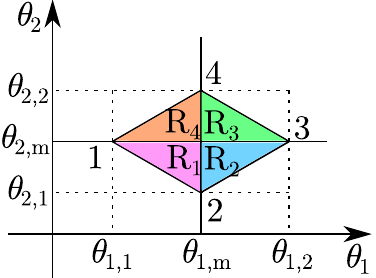
Figure 8. Definition of the regions in a generic O θ 1 θ 2